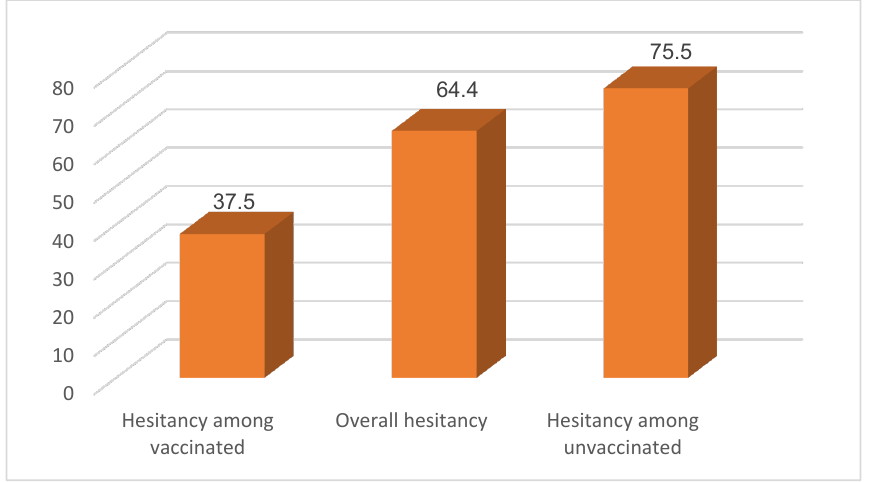
Figure 3. Level of vaccine hesitancy among survey participants at the time of the COVID-19 vaccine hesitancy survey, Ethiopia, 2022.